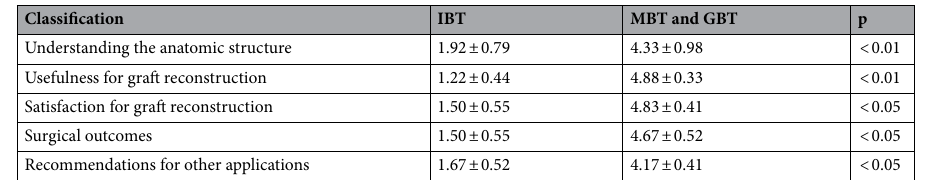
Table 4. Retrospective survey in relation to understanding, usefulness, satisfaction, surgical outcome, and recommendability for use in other applications for IBT without 3D printing technique and MBT and GBT with 3D printing